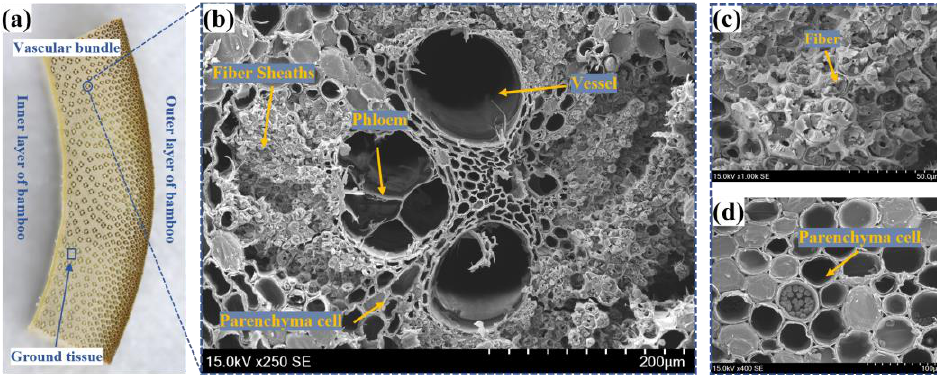
Figure 1. The macroscopic and microscopic structure of moso bamboo: ( a ) radial section of bamboo; ( b ) microstructure from the cross-section; ( c ) fiber sheaths observed from the cross-section; ( d ) parenchymal cells observed from the cross section.